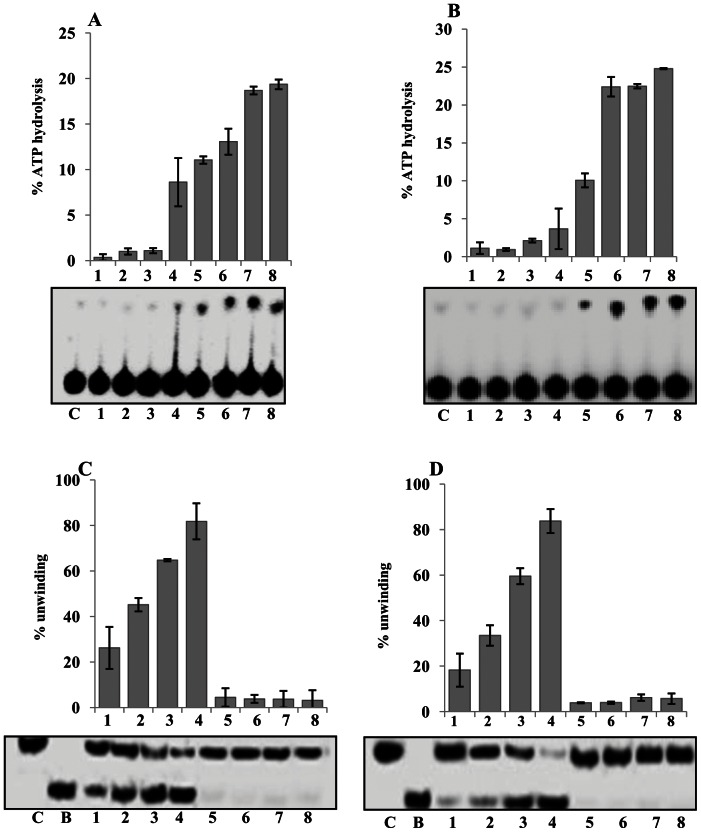
Analysis of ATPase and helicase activities after immunodepletion.A. ATPase activity of sUD. Lanes 1–3, reactions with increasing concentration of sUD pretreated with immune IgG, lanes 4–8 reactions with increasing concentration of sUD pretreated with pre-immune IgG. B. ATPase activity of sUDN1N2. Lanes 1–3, reactions with increasing concentration of sUDN1N2 pretreated with immune IgG, lanes 4–8 reactions with increasing concentration of sUDN1N2 pretreated with pre-immune IgG. Lane C in A and B is reaction without protein. C. Helicase activity of sUD. Lanes 1–4, reactions with increasing concentration of sUD pretreated with pre-immune IgG, lanes 5–8, reactions with increasing concentration of sUD pretreated with immune IgG. D. Helicase activity of sUDN1N2. Lanes 1–4, reactions with increasing concentration of sUDN1N2 pretreated with pre-immune IgG, lanes 5–8 reactions with increasing concentration of sUDN1N2 pretreated with immune IgG. In panel C and D, lane C is reaction without protein and lane B is heat treated substrate. In each panel the quantitative data from the autoradiogram are also shown.